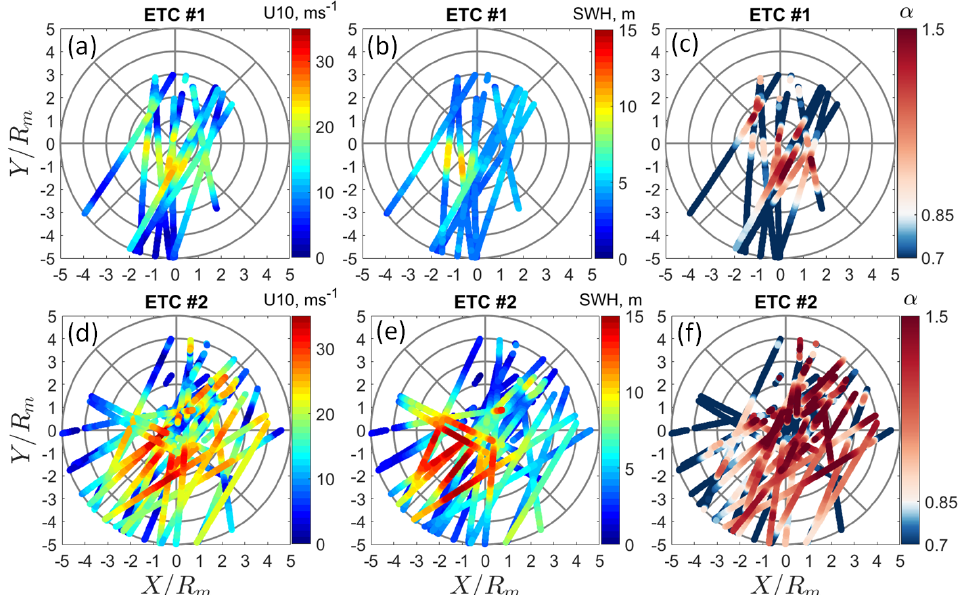
Figure 9. Along − track wind speed, SWH, and α inside the cyclone in a coordinate system associated with the coordinates of ETCs considering their heading aligned in x -direction, respectively, illustrated in ( a – c ) for ETC#1 and ( d – f ) for